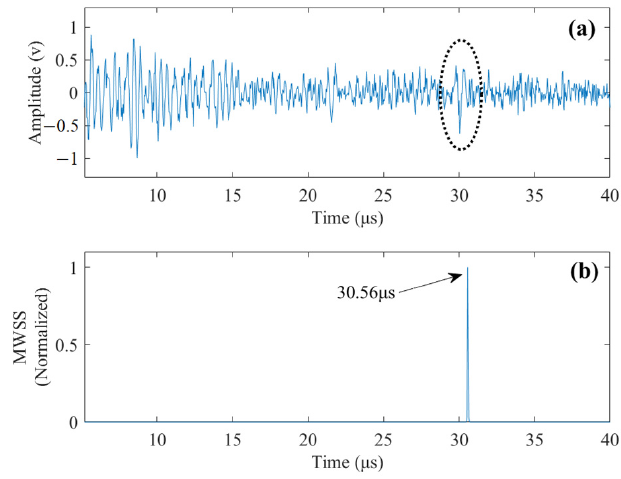
Figure 4. ( a ) Simulated noisy signal, LSNR = 0 dB. ( b ) The MWSSs by the proposed method.